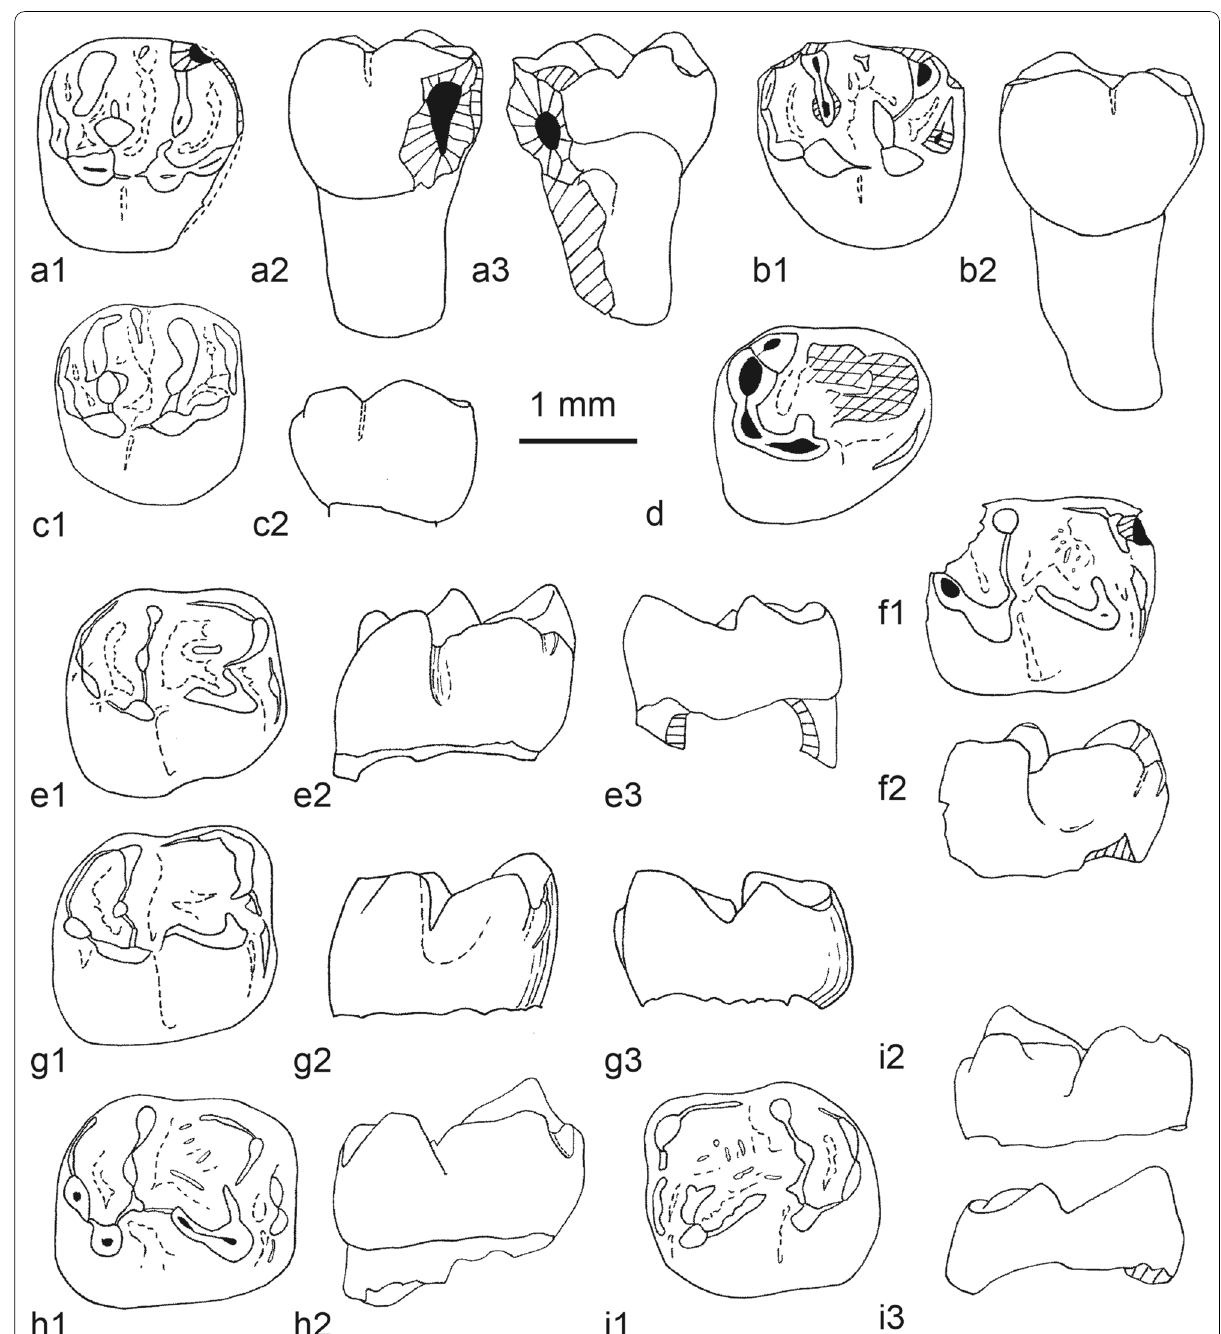
Fig. 12 Teeth of Protadelomys cartieri (Stehlin & Schaub, 1951), from Laprade (Quercy). a LAP 259, right M1; a1, occlusal view; a2, lingual aspect; a3, buccal aspect. b LAP 260 left M2; b1, occlusal view; b2, lingual aspect. c : LAP 193, right M2; c1, occlusal view; c2, lingual aspect. d LAP 211, right p4, occlusal view. e LAP 222, right m1; e1, occlusal view; e2: buccal aspect; e3: lingual aspect. f LAP 258, right m2; f1, occlusal view; f2: lingual aspect. g LAP 213, right m2; g1, occlusal view; g2: lingual aspect; g3: buccal aspect. h LAP 228, right m2; h1, occlusal view; h2: buccal aspect. i : LAP 226, left m2; i1, occlusal view; i2: buccal aspect; i3: lingual aspect. Scale bar: 1